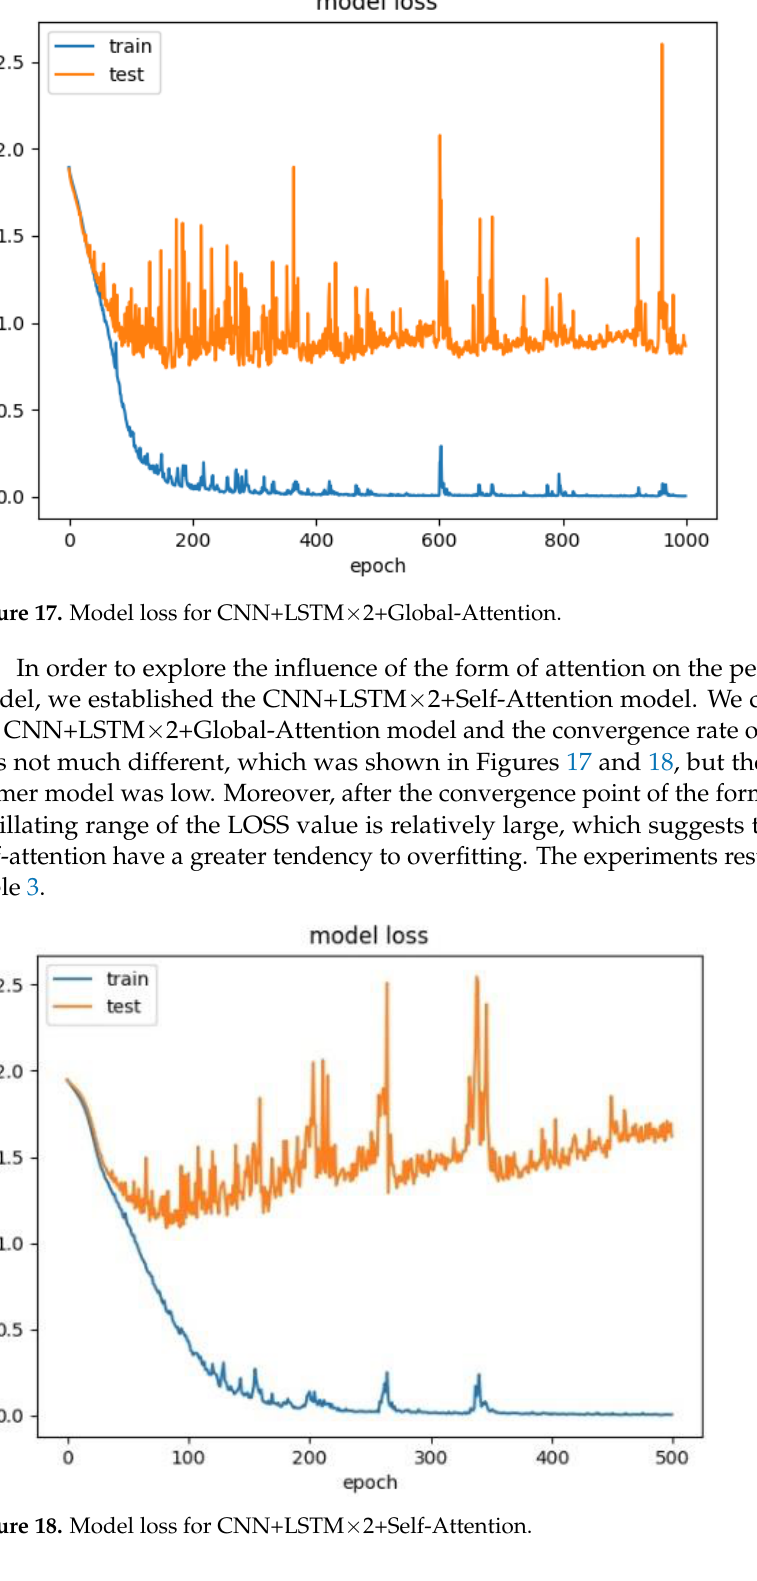
Figure 16. Model loss for CNN+LSTM+Global-Attention+LSTM.